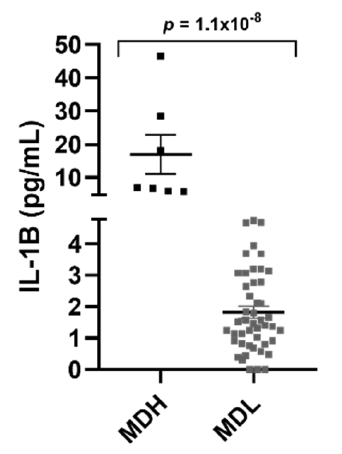
Figure 3. MD patients separated according to their IL-1 β levels (MDH (>4.78 pg/mL) and MDL (<4.78 pg/mL)).